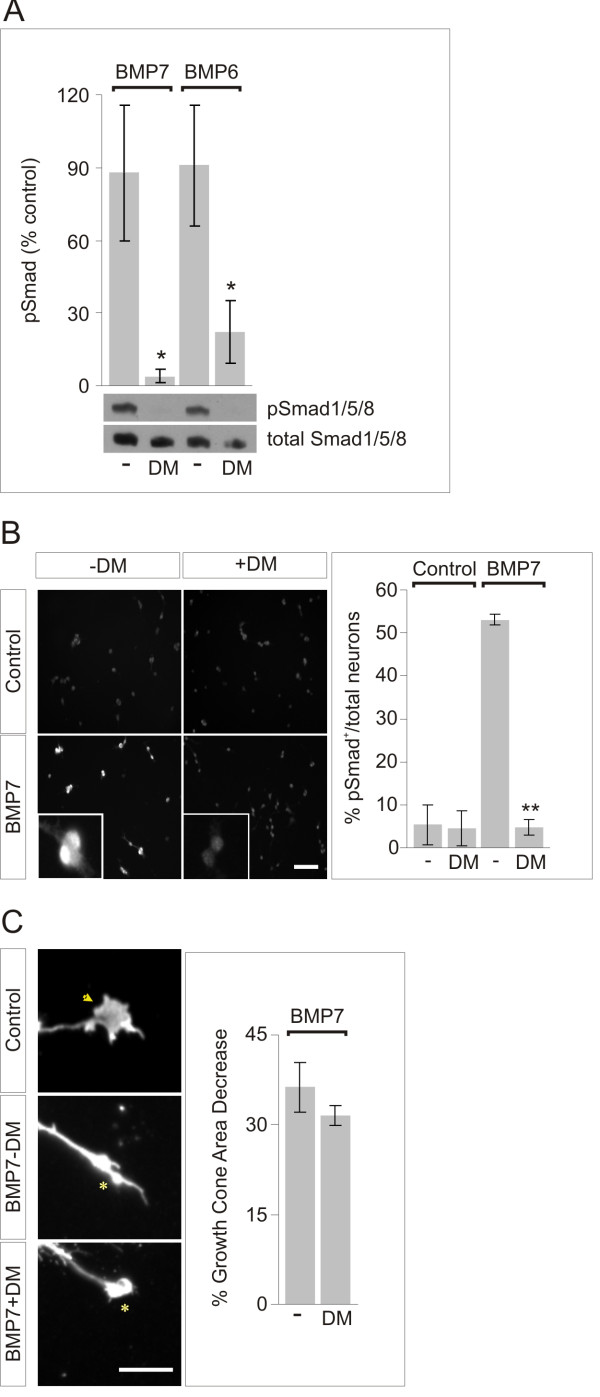
BMP-evoked Smad1/5/8 phosphorylation, but not collapse activity, depends on type I BMP receptor kinase activity. (A) Whole cell lysates of dissociated dI neurons with or without DM (10 μM) and with or without BMP7 or BMP6 (50 ng/ml), probed and normalized on western blots as in Figure 1B. Results are expressed as percentage of control pSmad1/5/8 for each condition (BMP7 - DM = 188 ± 28%; BMP7 + DM = 104 ± 3%; BMP6 - DM = 191 ± 25%; BMP6 + DM = 122 ± 13%; n = 2). DM had no effect on baseline pSmad1/5/8 (control + DM = 100 ± 13%). pSmad1/5/8 responses to BMP7 and BMP6 treated with DM differ significantly from pSmad1/5/8 responses to BMP7 and BMP6 without DM (*P < 0.05, Mann-Whitney test). (B) Left: pSmad1/5/8 in dissociated dI neurons with or without BMP7 and with or without DM. Scale = 80 μm. Insets: pSmad1/5/8-positive and -negative neurons (scale = 10 μm). Right: the percentage of pSmad1/5/8+ neurons in control cultures with or without DM was unchanged (control - DM = 5.4 ± 4.7%; control + DM = 4.5 ± 4.1%; P = 0.8977, Student's t-test). The number of pSmad1/5/8+ cells in response to BMP7 with or without DM differed significantly (BMP7 - DM = 53.1 ± 1.2%; BMP7 + DM = 4.7 ± 1.8%; **P < 0.005, Student's t-test). Results are mean ± SEM for four 20 × fields: 150 to 500 neurons/condition/experiment (n = 2). (C) ERM-labeled dissociated dI neuron sister cultures, with or without BMP7 and with or without DM as in (B). The growth cone area in control cultures was not changed by DM (not shown; control - DM versus control + DM, P = 0.9215 (Student's t-test)). The percentage decrease in growth cone area in response to BMP7 was not significantly altered by DM: control + DM = 1.3 ± 11%; BMP7 - DM = 36 ± 4%; BMP7 + DM = 32 ± 2%; n = 2; BMP7 - DM versus BMP7 + DM, P = 0.4097 (Student's t-test)). Arrowhead indicates control growth cone and asterisks indicate collapsed growth cones. Scale = 10 μm.